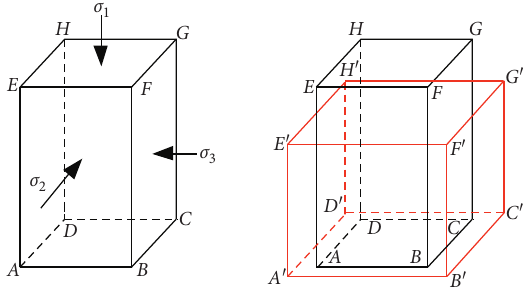
Figure 2: Cubic specimen under true triaxial